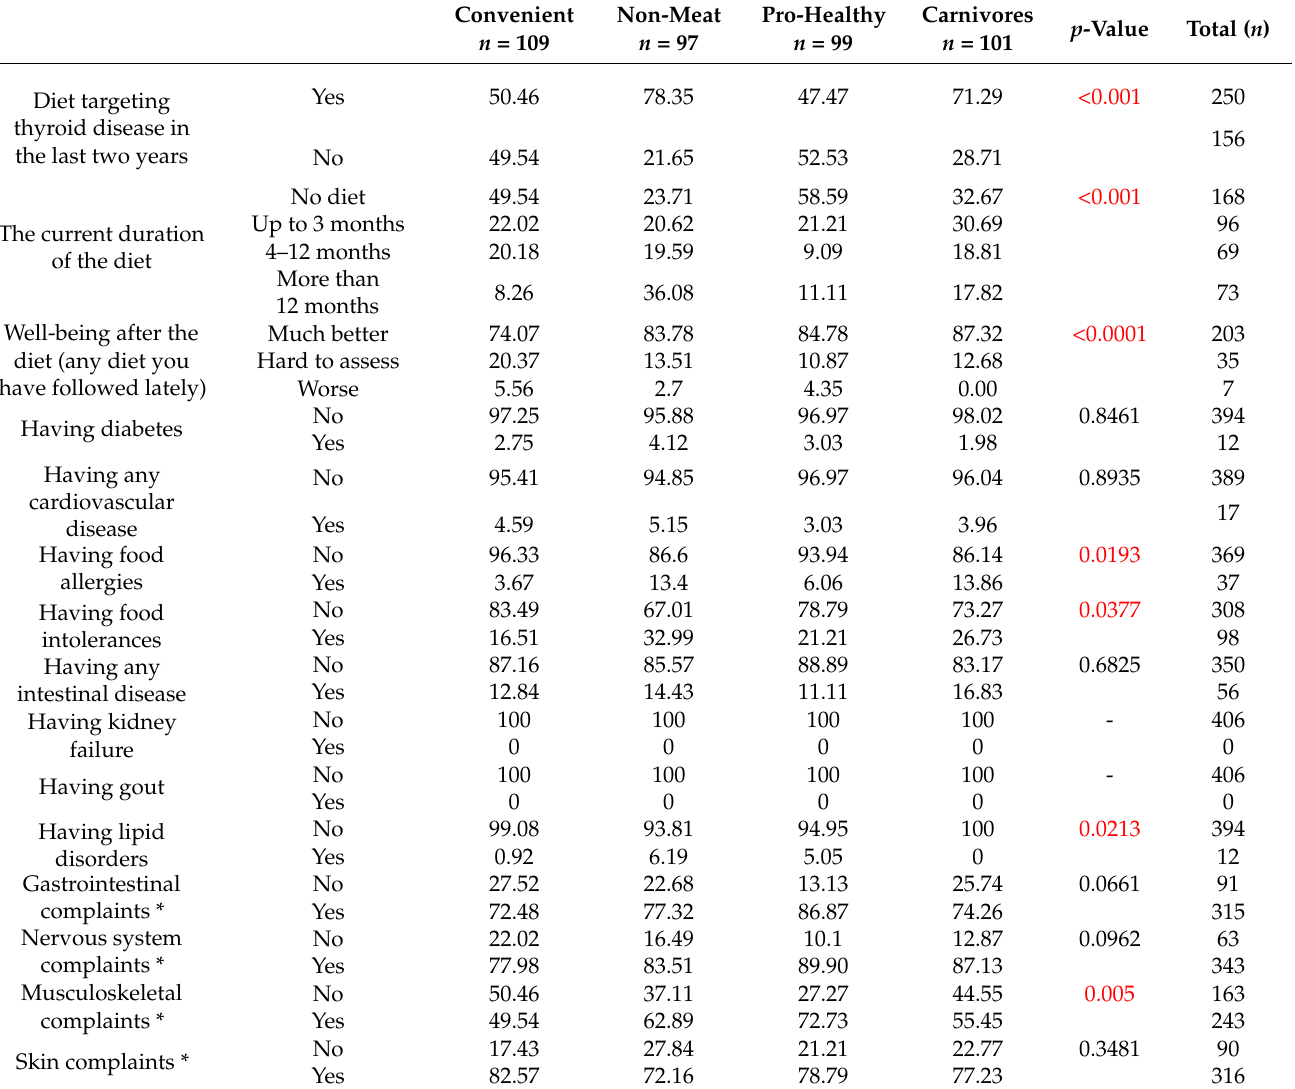
Table 4. Characteristics of the respondents by diseases, well-being, diet, and dietary patterns